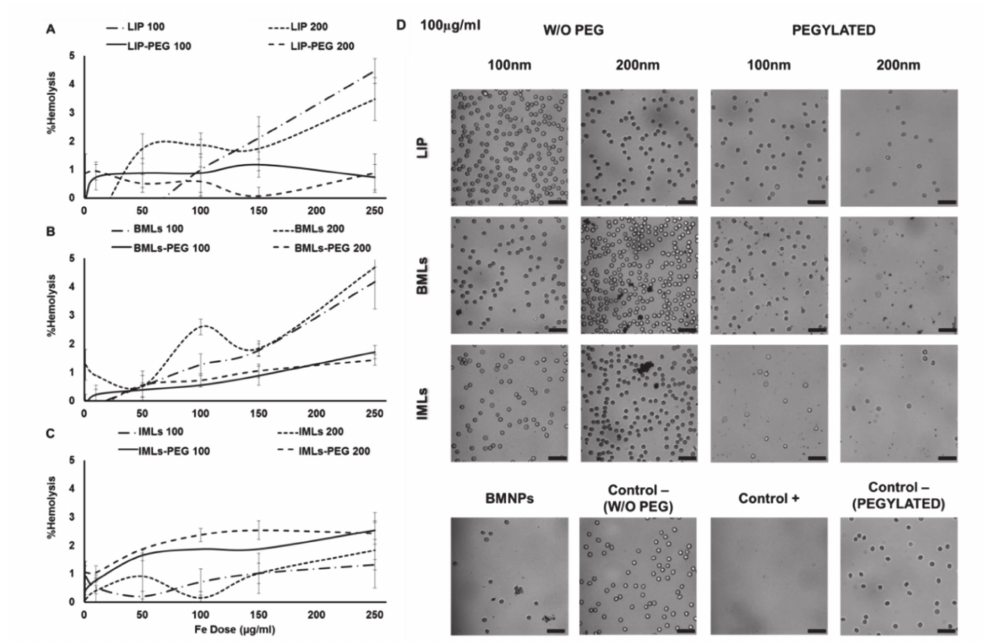
Figure 2. LIP, BMLs and IMLs biocompatibility with red blood cells. Hemolysis test with ( A ) LIP, ( B ) BMLs and ( C ) IMLs. Data represent the mean values ± SD of triplicate samples. ( D ) Images of optical microscopy of erythrocytes after treatment with the di ff erent nanoformulations at 100 µ g / mL of Fe. Scale bar 25 µ m.